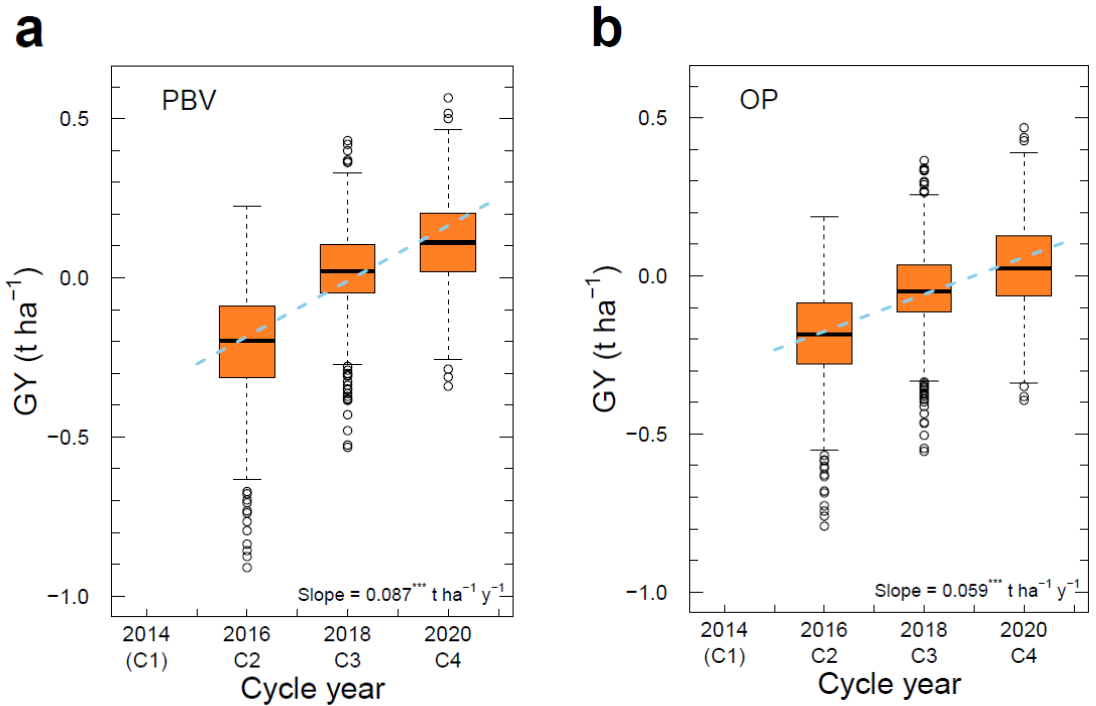
Figure 8. Genetic gain per year for grain yield (GY, t ha − 1 ) based on the slope of the linear regression expressed in t ha − 1 y − 1 of ( a ) PBV averaged across environments of candidates in cycle 2 (2016 C2), cycle 3 (2018 C3) and cycle 4 (2020 C4), and ( b ) OP values over cycle 2, cycle 3 and cycle 4. Box plots represent the range of PBV and OP of candidates in each cycle. PBV and OP were obtained from the optimum MMM-FA model of the genotype × environment interaction effects. Data from cycle 1 (2014 C1) were excluded from the analysis, so C1 is shown in parentheses. Significance of the slope of the linear regressions: *** p < 0.001.